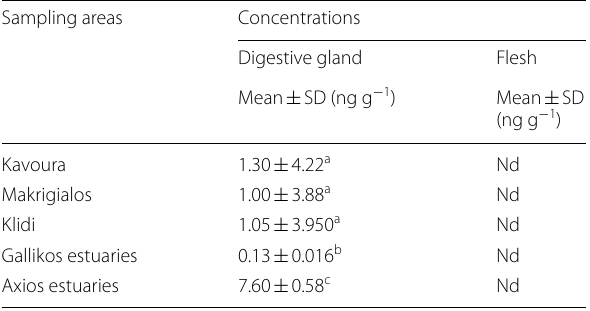
Nd not detected at levels higher than limit of detection (LOD) SD standard deviation Values with different superscript indicate difference at the 5% significance level